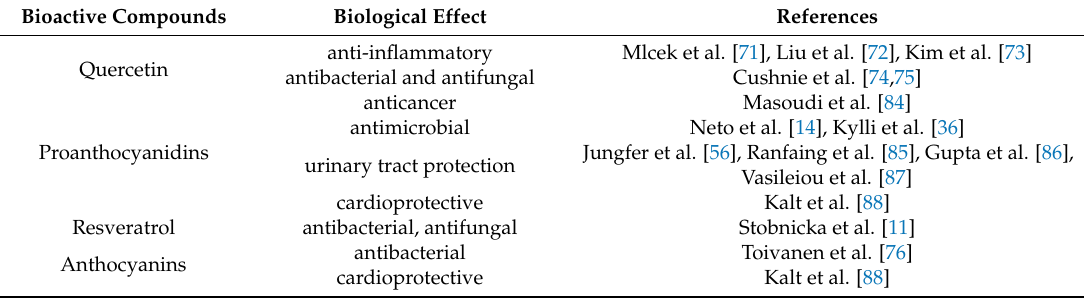
Table 3. The major bioactive compounds of European cranberry fruit and their effect.